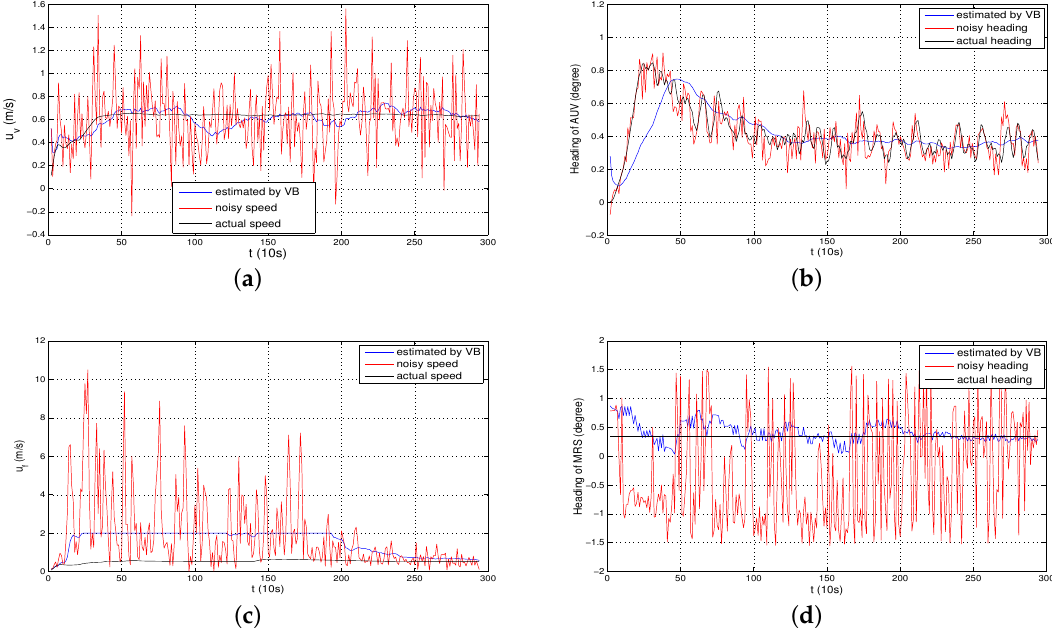
Figure 8. The forward speed and heading of AUV and MRS, in which ( a ) illustrates the forward speed of AUV in global frame; ( b ) illustrates the heading of AUV in global frame; ( c ) illustrates the forward speed of MRS in global frame; ( d ) illustrates the heading of MRS in global frame.